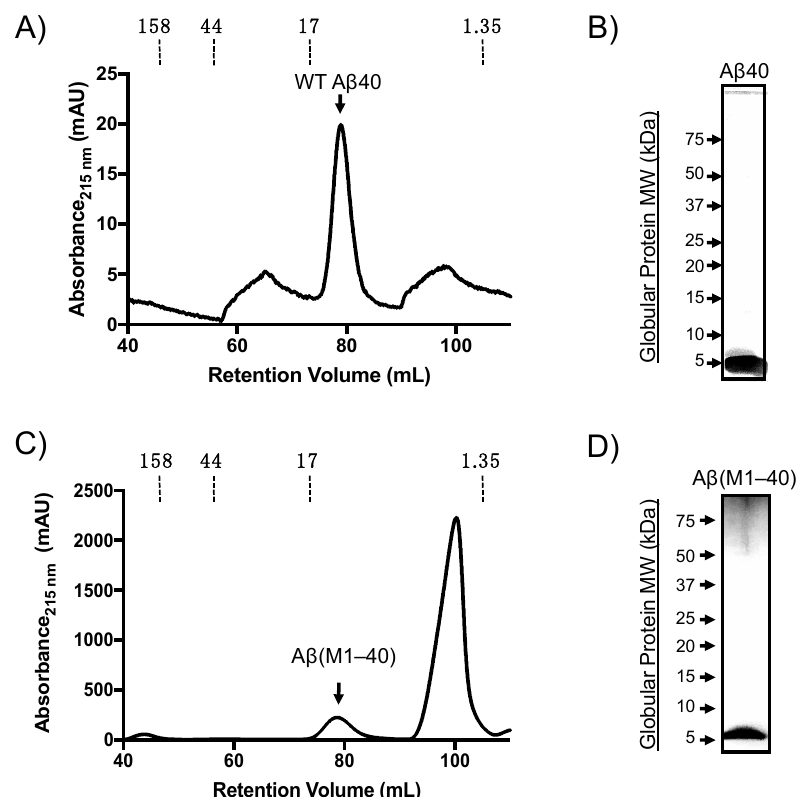
Figure 1. Purification of synthetic and recombinant amyloid- β peptide (A β ) monomer by size-exclusion chromatography (SEC). ( A ) Representative SEC chromatogram of synthetic wild-type (WT) A β 40 monomer. ( B ) Silver-stained SDS-PAGE gel of monomeric A β 40 separated on Criterion ™ XT 4–12% bis-tris gradient gels. Globular protein standard molecular weights (left side) are provided for reference. ( C ) SEC chromatogram of A β (M1–40) from denatured inclusion bodies following anion-exchange chromatography. ( D ) Silver-stain SDS-PAGE gel of A β (M1–40) collected from SEC.